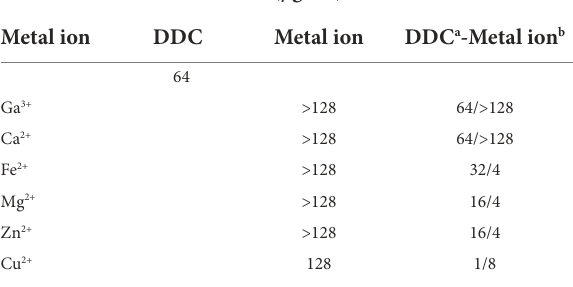
TABLE 1 Minimum inhibitory concentration (MIC) of diethyldithiocarbamate (DDC), metal ions and the combination of both against S. epidermidis ATCC